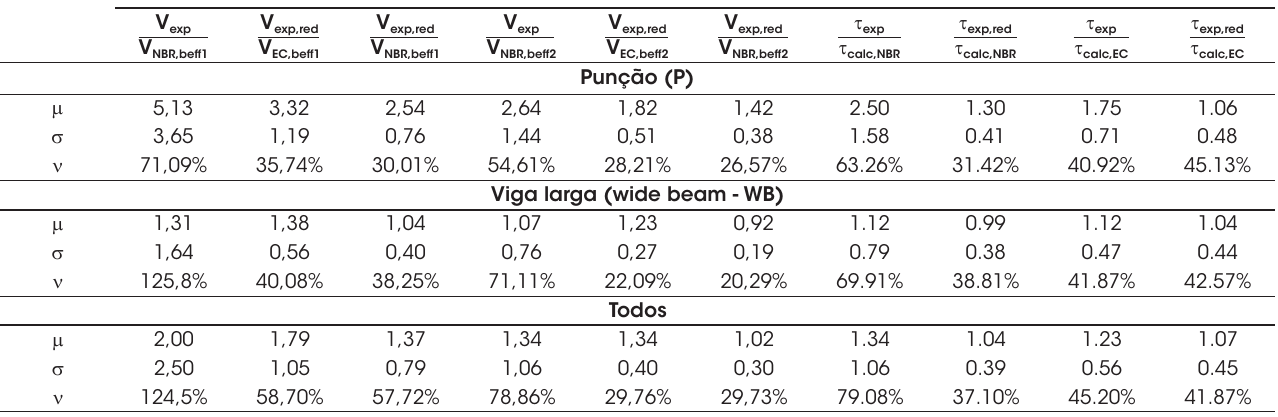
= 1) according to the c